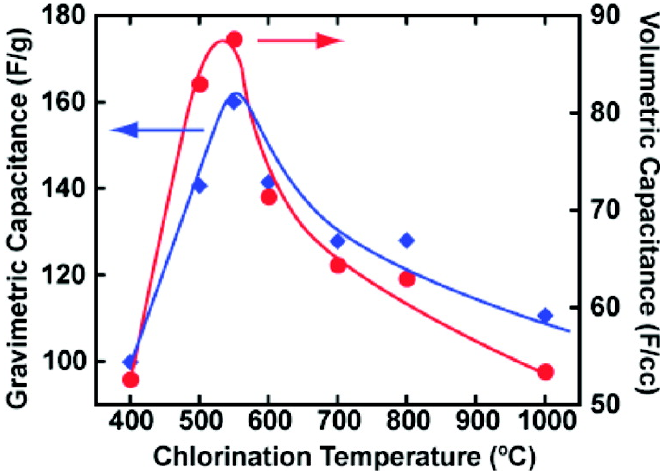
Figure 6. Specific gravimetric (F g − 1 ) and volumetric (F cm − 3 ) capacitances change depending on the chlorination temperature for CDC electrodes tested in neat [EMI][TFSI] electrolytes at 60 °C. Reprinted 2008 from [88] with permission from the American Chemical Society.